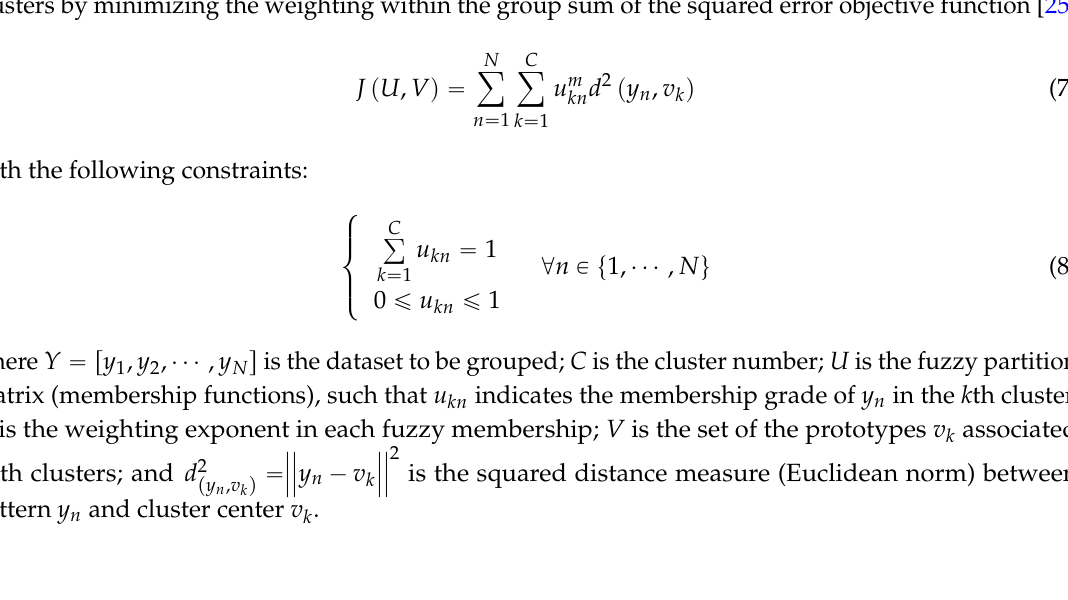
Figure 2. Examples of difference image histogram h p i ρ q and definitions of uncertain and nearly certain parts.